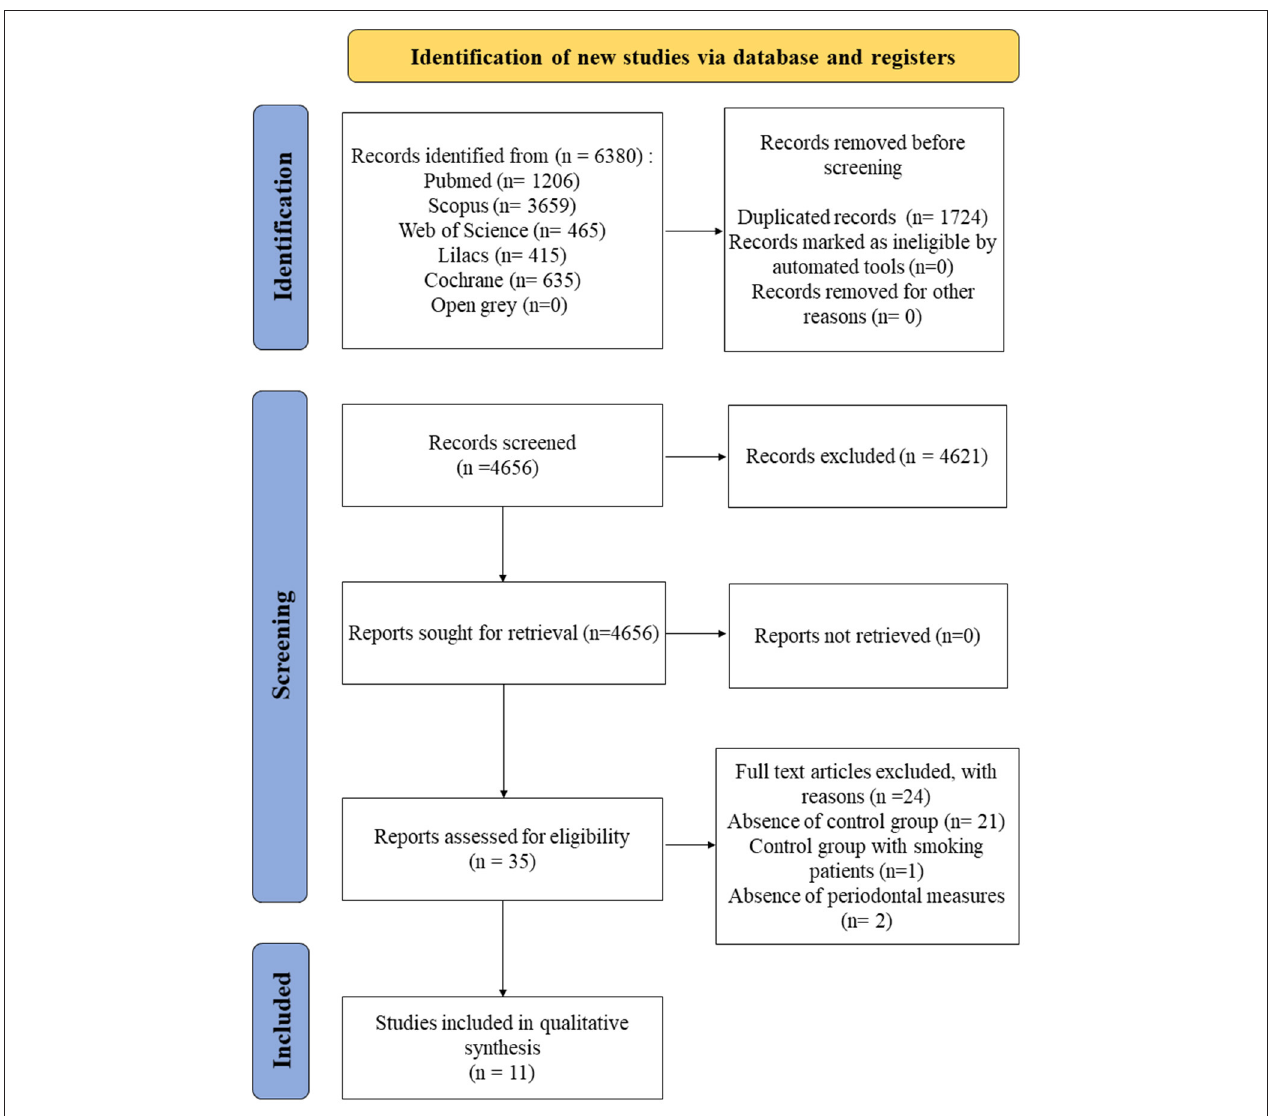
FIGURE 1 | Flowchart of selection of studies according to the PRISMA